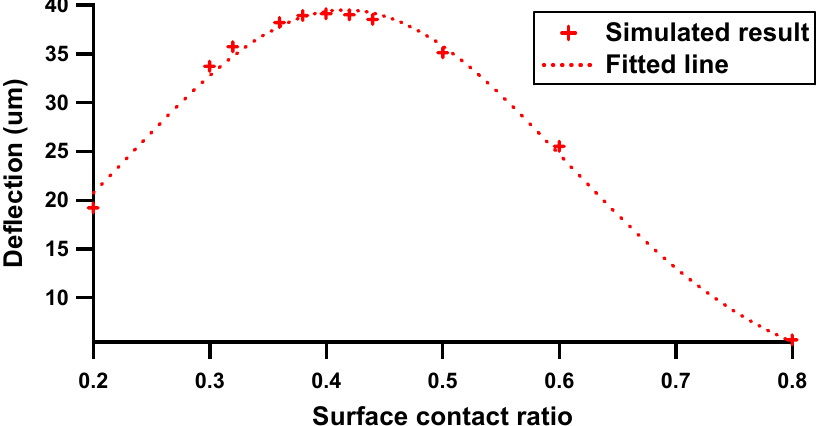
Figure 4. Membrane deflection with surface contact ratio